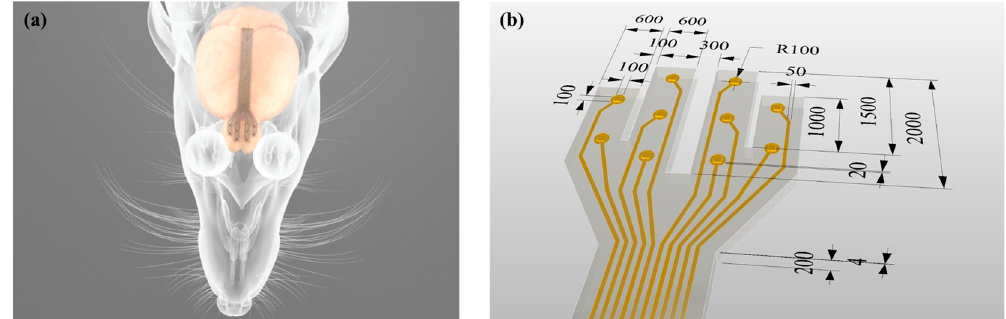
Figure 1. Schematic of the micro-electrode arrays (MEA) with ten convex electrode sites in four arms for in vivo Electrocorticography (ECoG) recording from rat olfactory bulb. ( a ) Experimental setup. ( b ) The overall dimensions of the MEA. The unit of length is micrometer ( μ m).